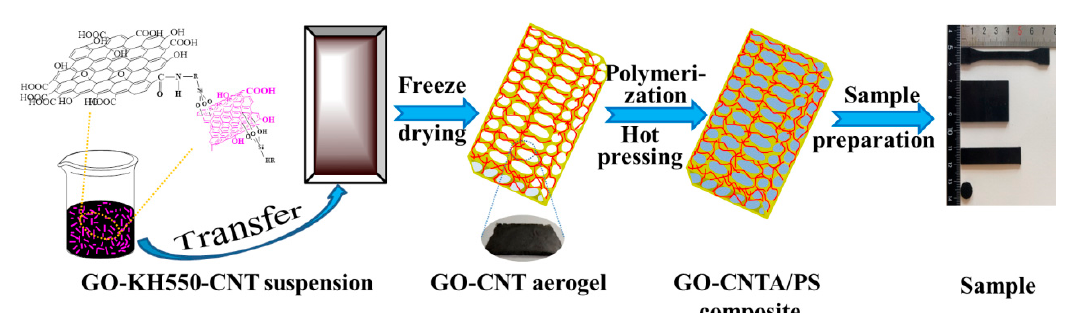
Figure 2. Preparation process of composite material. Table 1. Abbreviation of sample.